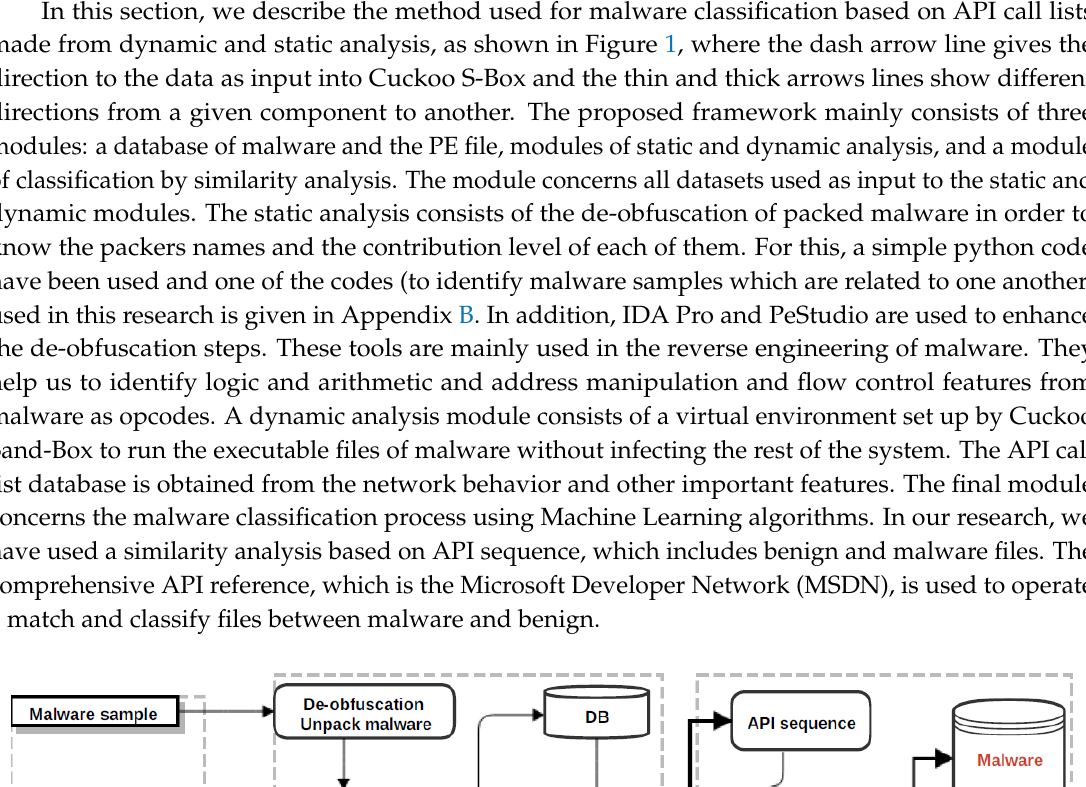
Table 1. Summary of dataset created as per VirusTotal. 169